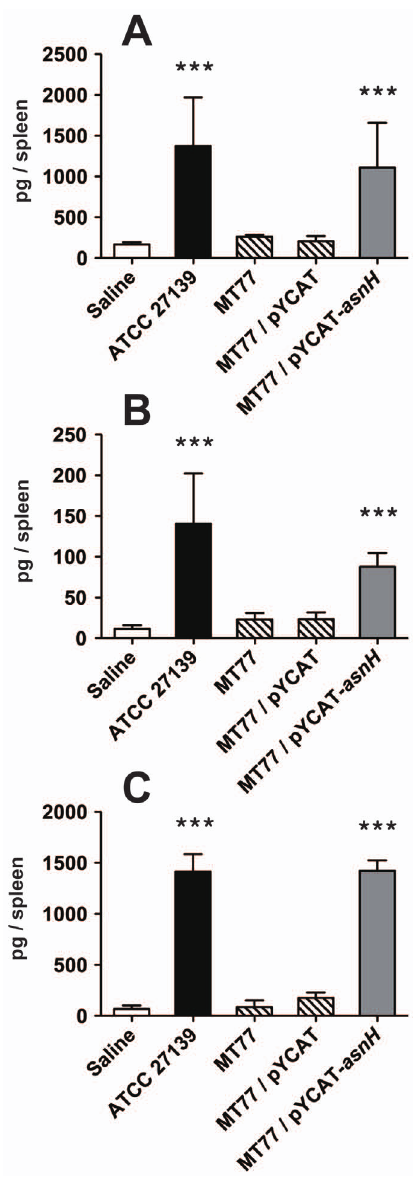
Figure 2. Induction of cytokine in spleen after L. casei administration. Heat-killed preparations of L. casei ATCC 27139 or isogenic Tn 5 insertion mutants (800 m g) were injected i.v. into BALB/c mice. Six mice per group were sacrificed 8 h after injection, and IL-12 (A), TNF- a (B), and IFN- c (C) proteins were measured from spleen homogenates by ELISA. Columns: white, saline; black, L. casei wild-type; slashed, L. casei J1 phage-resistant mutant; gray, L. casei asnH mutant complemented with the cloned asnH . Results are depicted as the means 6 standard deviations (SD). Statistical significance was calculated using the Student’s t -test. Significant differences indicated between the control and treated groups. ***, p , 0.001.